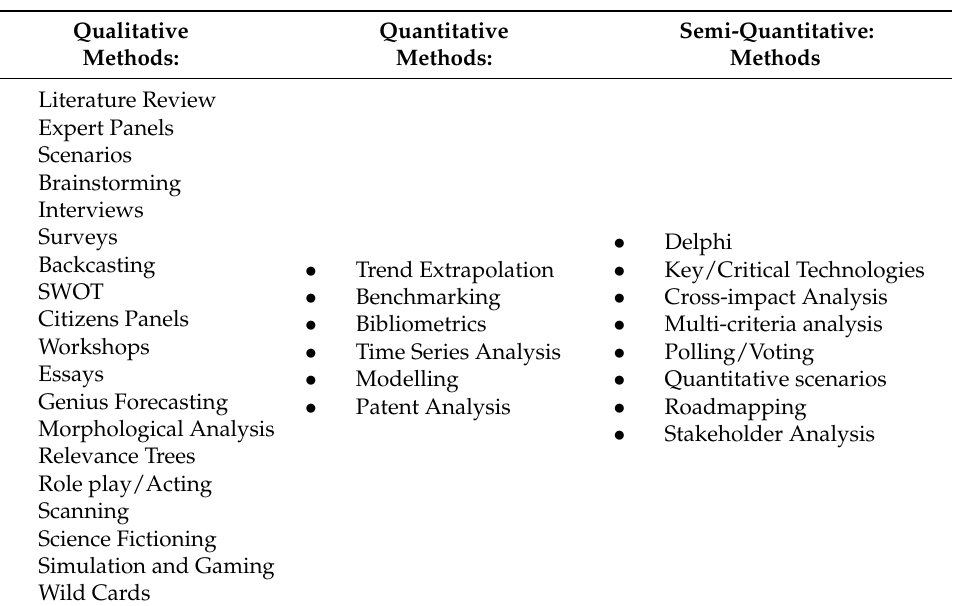
Table 2. 33 Foresight methods. Source: